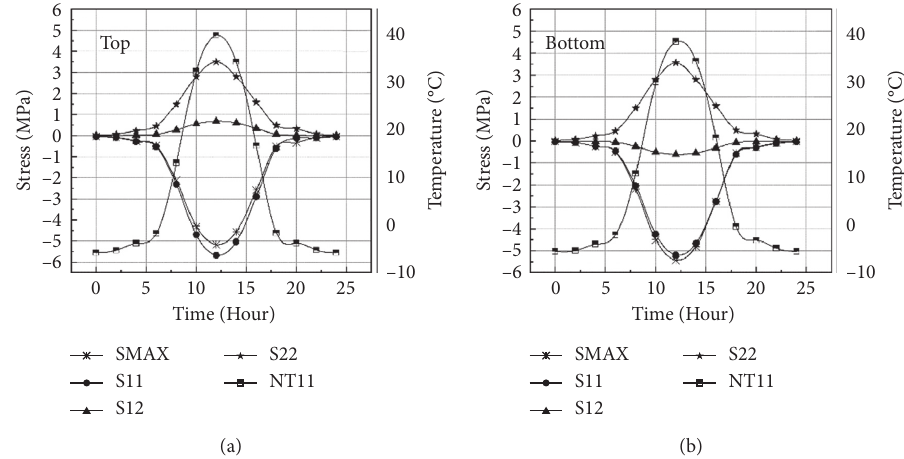
Figure 7: Time-history response curve of stresses above void area in the “normal” condition in the winter: (a) slab top and (b) slab bottom.